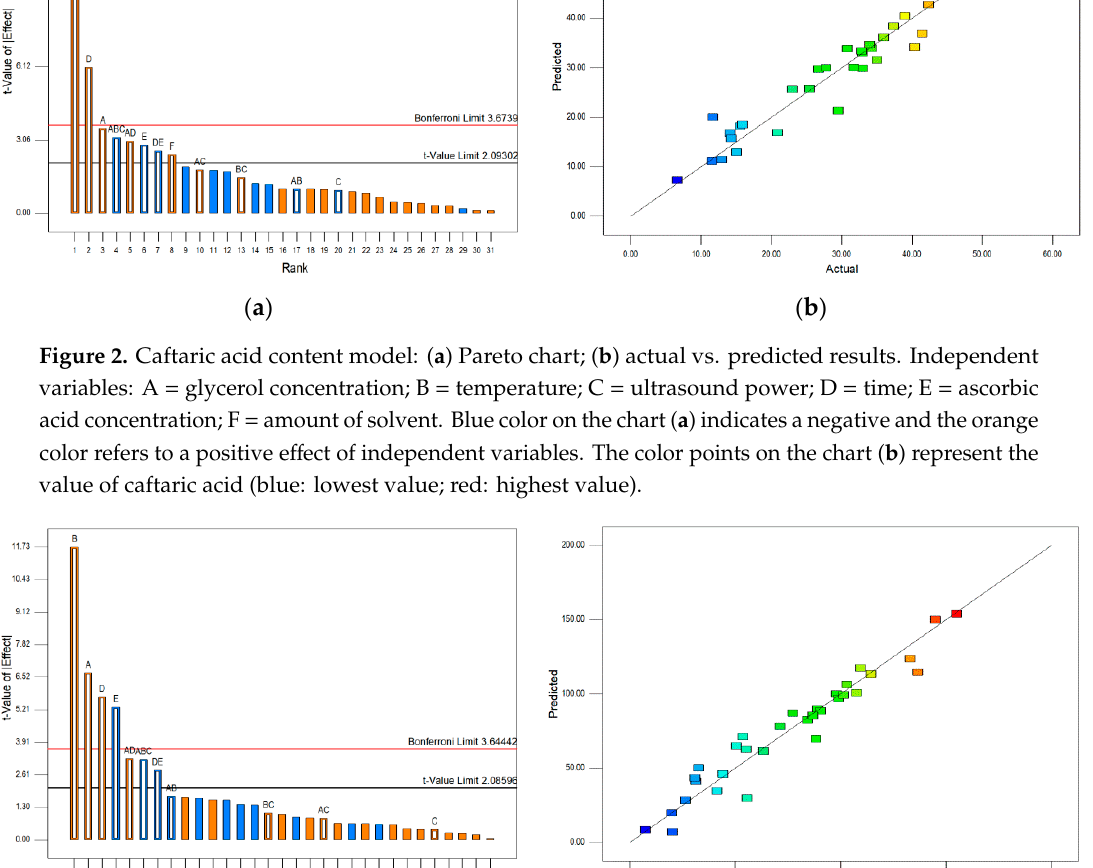
( b ) Figure 4. Total phenolic acid content model: ( a ) Pareto chart; ( b ) actual vs. predicted results. Independent variables: A = glycerol concentration; B = temperature; C = ultrasound power; D = time; E = ascorbic acid concentration. Blue color on the chart ( a ) indicates a negative and the orange color refers to a positive effect of independent variables. The color points on the chart ( b ) represent the value of total phenolic acid (blue: lowest value; red: highest value). The Pareto charts illustrating the effects of the extraction conditions on the contents of cichoric acid (Figure 3a) and TPA (Figure 4a) were rather similar due to the cichoric acid being the most abundant phenolic acid and contributing largely to TPA. The Bonferroni limit and the t -value limit were also rather similar, with the t -values of the effects being approximately 3.6 and 2.09, respectively. Variables with coefficients above the Bonferroni limit, such as A, B, D, and E, were significant model factors. Similarly, the terms AD, DE, and ABC, which fell between the Bonferroni limit and the t -value limit, were considered likely to be significant factors. The color codes indicate that A, B, D, and AD positively affected extraction efficiency, while E, DE, and ABC influenced the extraction negatively. The predicted and measured values were in good agreement (Figures 3b and 4b). 2.4. Metal Content in E. Purpurea Aerial Parts The contents of selected transition and second group metals were determined (Table 4). It was found that the plant material contains several elements, the presence of which may influence the anti-